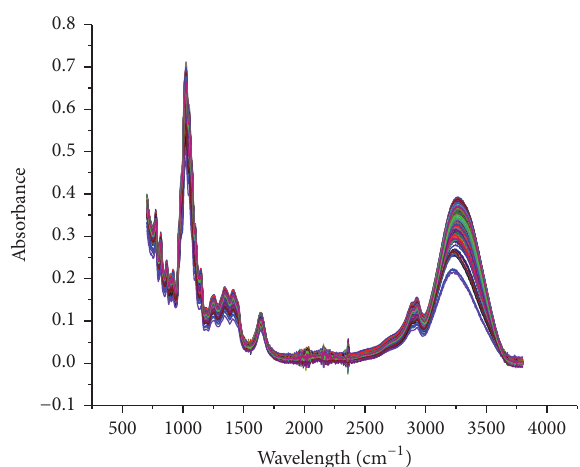
Figure 2: Characteristic of FTIR-ATR spectrum from all honeys samples, acquired from 3700 to 700 cm −1